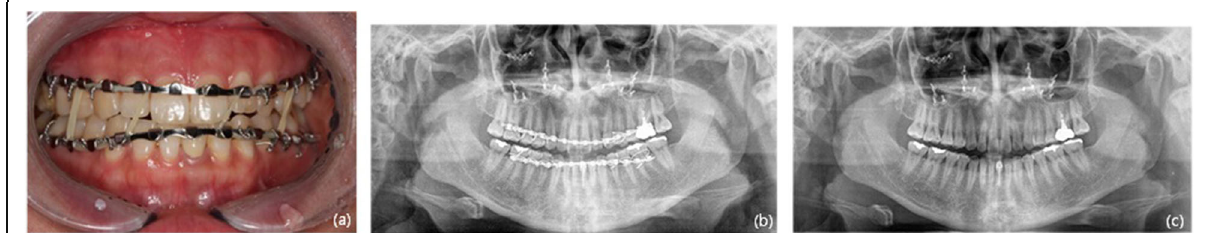
Fig. 3 a Clinical photograph at 1 month after operation showing resolution of the malocclusion. b Panoramic radiograph at 1 month after operation. c Panoramic radiograph at 1 year after the operation